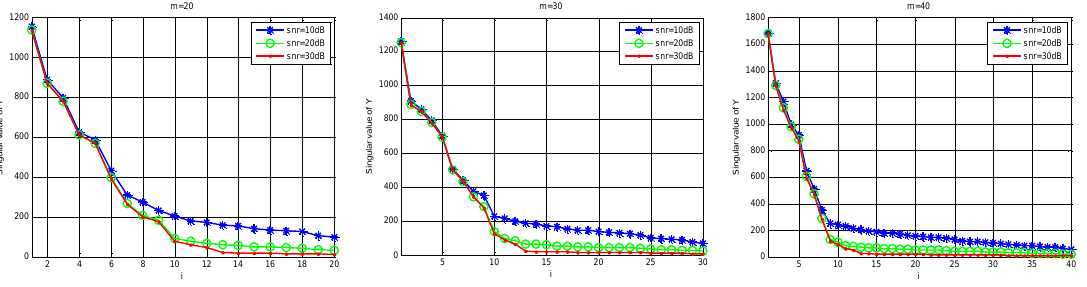
Figure 4. The comparison of the singular value of Y under different SNR environments.